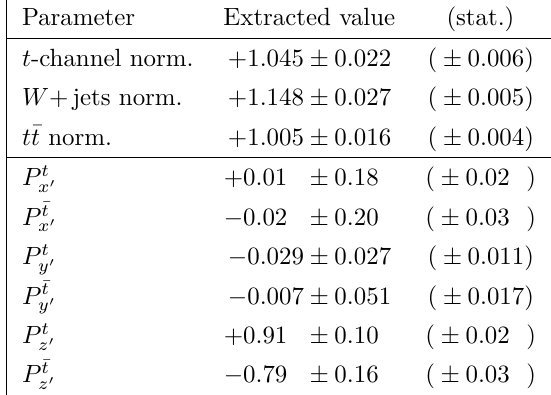
Table 4 . Normalisation factors of the t -channel, W + jets and t ¯ t processes together with the polarisation values as extracted from data, including total and statistical-only uncertainties in the fit.